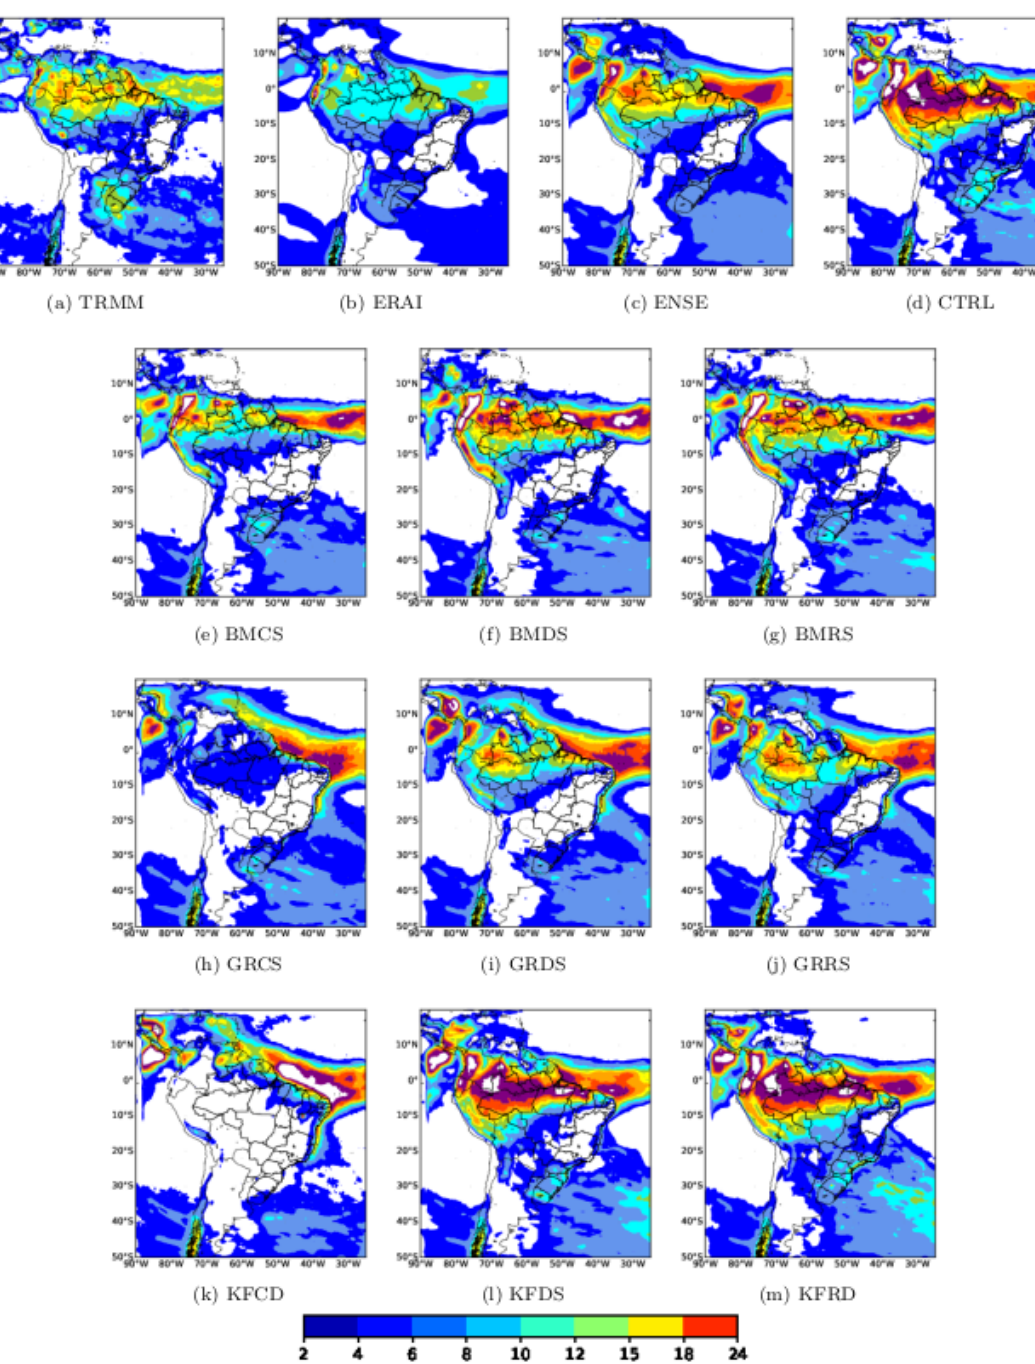
Figure 4. As in Figure 3, but for March–April–May